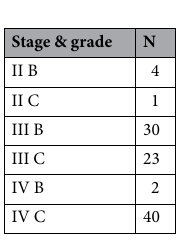
Table 1. Staging and Grading 40 of included participants (N = 100).